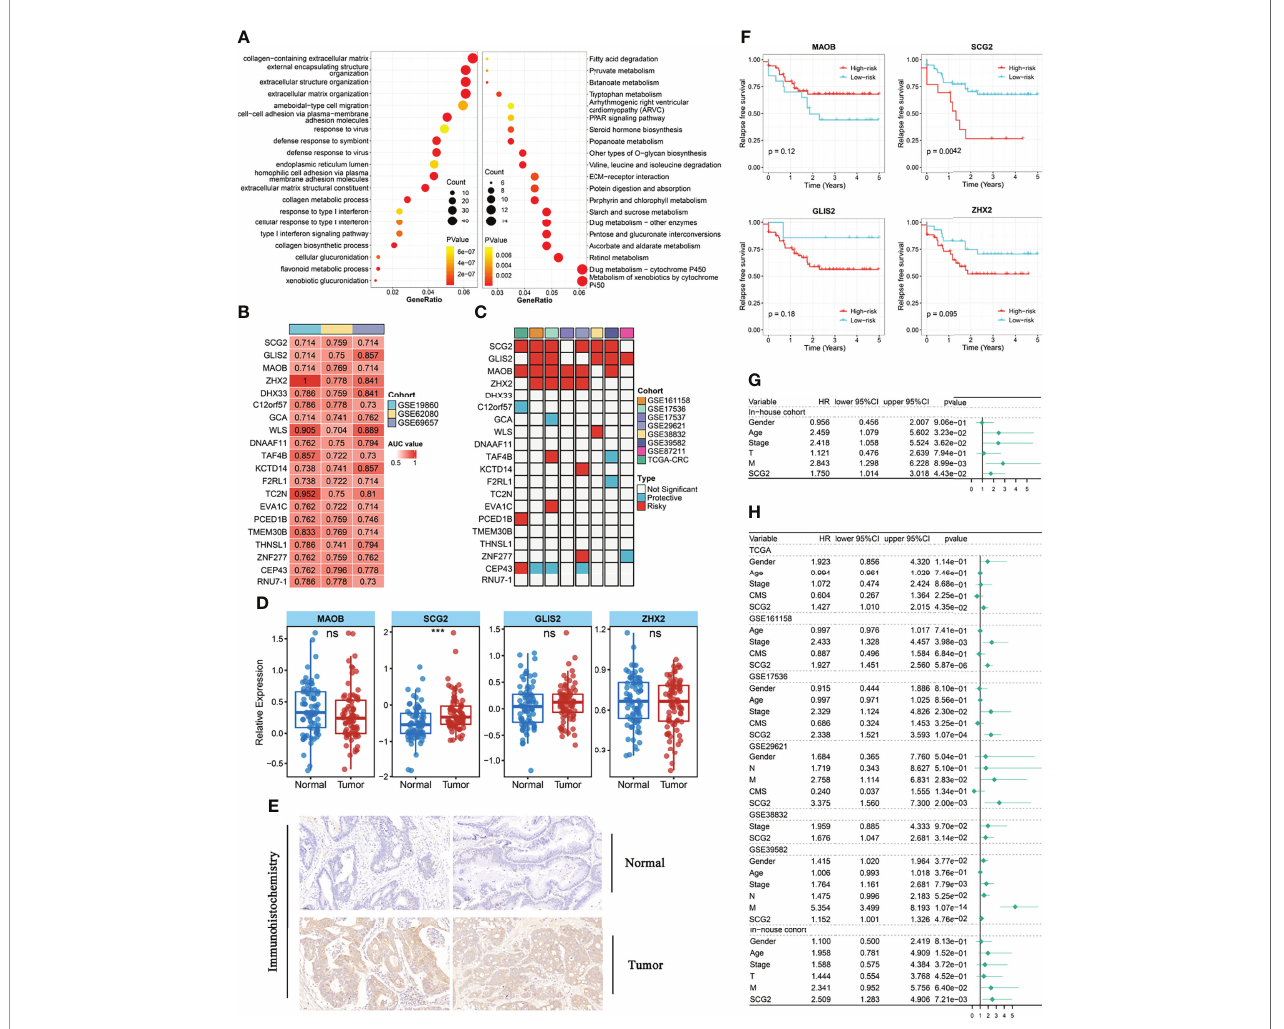
FIGURE 3 | Functional analysis and identify prognostic genes in modules. (A) Gene ontology (GO) and Kyoto Encyclopedia of Genes and Genomes (KEGG) enrichment analysis of genes in key modules. (B) The 20 module genes with AUC values >0.7 in all chemotherapy cohorts. (C) Univariate analysis with relapse-free survival (RFS) as the outcome event and the expression of the above 20 genes as independent variables. (D) Different expression of GILS2, MAOB, SCG2, ZHX2 between tumor and normal tissues in the internal cohort. (E) Representative IHC staining images of SCG2 between colorectal cancer and normal tissue. (F) Survival analysis of in-house cohort with RFS. (G) Univariate analysis of internal cohort with relapse-free survival (RFS) as the outcome event. (H) Multi-factor regression analysis of internal and external queues with relapse-free survival (RFS) as the outcome event. ns, P > 0.05; *** P <